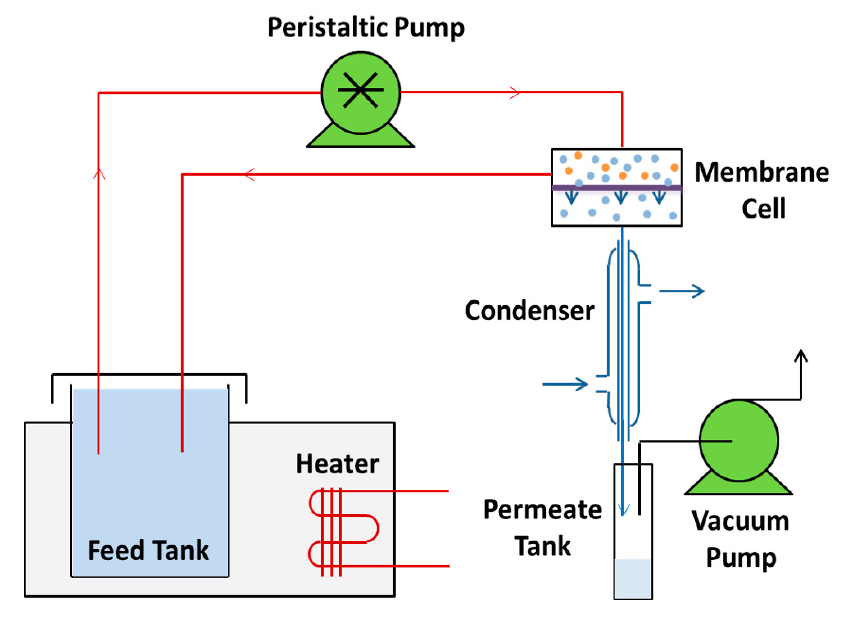
Figure 1. Schematic of pervaporation testing unit.